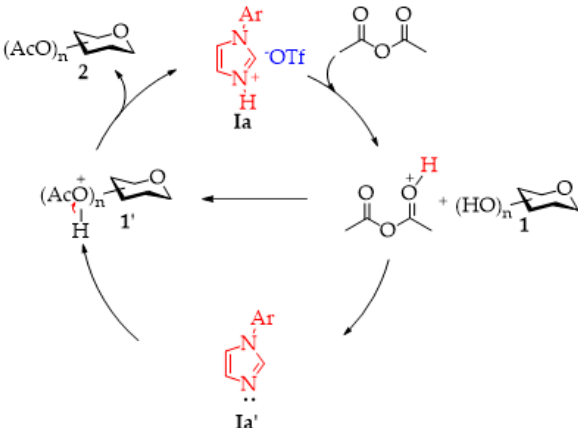
Scheme 2. A plausible mechanism of the per- O -acetylation reaction.